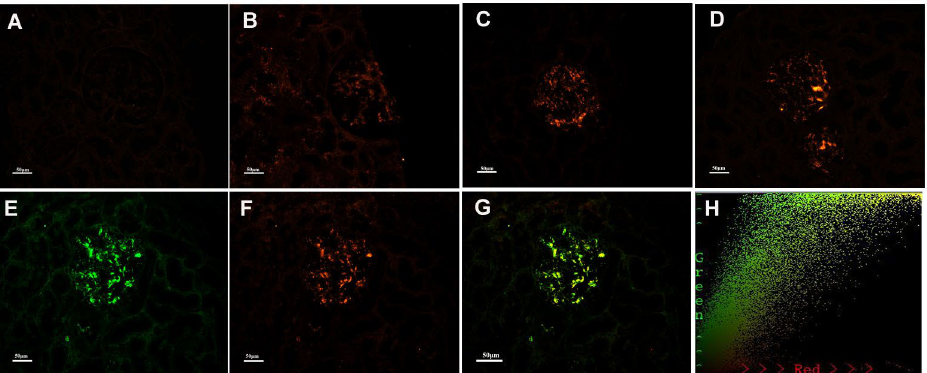
Figure 3. Representative images of immunofluorescence staining for KM55 in patients with PMN/IgAN, ( A ) Negative, ( B ) 1+ intensity, ( C ) 2+ intensity, ( D ) 3+ intensity. Positive staining of KM55 3+ ( F ) by immunofluorescence along the glomerular mesangial and capillary area in the same section with IgA positive staining ( E ). ( G )KM55 and IgA colocalized completely along the glomer- ular mesangial and capillary area. The corresponding two-dimensional (2D) fluorograms have been included to confirm the degree of co-localization ( H : Pearson’s correlation 0.9182, Overlap coeffi- cient 0.9245;). ( A – G : original magnification ×200). Patients with PMN/IgAN had a lower frequency of serum anti-PLA2R antibody pos- itivity (43.5% versus 61.4%, p = 0.010; 20RU/mL as the cut-off value) and lower titers of antibody (8.2 versus 47.1 RU/mL, p < 0.001). The positive rates of tissue staining for PLA2R were lower in PMN/IgAN, compared to PMN/IgA deposition group (76.5% versus 98.5%, p < 0.001). 3.4. Baseline Clinical and Pathological Characteristics between Glomerular KM55+ Subgroup and KM55- Subgroup in PMN/IgAN Patients Compared to patients in KM55-subgroup, patients in KM55+ subgroup had a higher frequency of hypertension (60% versus 32.3%, p = 0.026) and a lower level of 24-h pro- teinuria excretion (3.8 versus 5.8g/d, p = 0.040). All the other demographic features and serum test results were comparable in the two groups (Table 4). Additionally, the propor- tion of Churg stage I was lower, while Churg stage II was higher in the KM55+ group ( p = 0.017). Patients in KM55+ subgroup had severer interstitial fibrosis. There was no signifi- cant difference in the distribution of positive glomerular IgG, IgG subclass and predomi- nant IgG subclass (IgG4), C1q, C3. Details of the pathological features are shown in Table 5. Table 4. Demographics and clinical features in PMN/IgAN patients based on the staining of glo- merular KM55. Characteristics